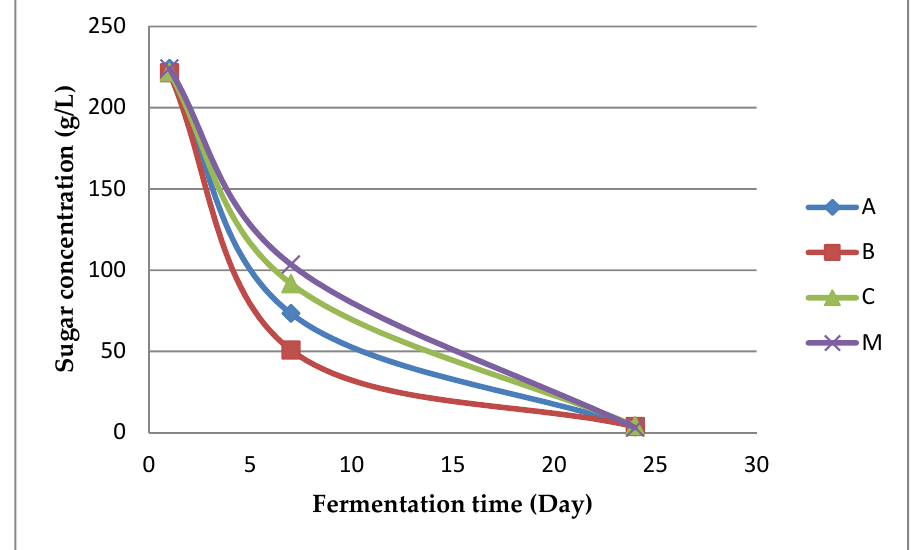
Figure 2. Sugar consumption (g/L) during pilot fermentation in the winery. A: wine inoculated by the strain M.6.16; B: wine inoculated by the strain M.10.16; C: wine inoculated by the strain M.4.17; M: wine fermented spontaneously (control).